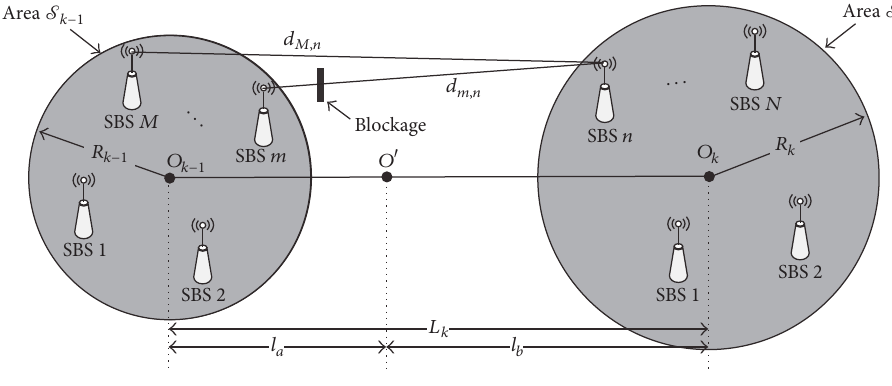
Figure 3: Intercluster mm-Wave wireless backhaul